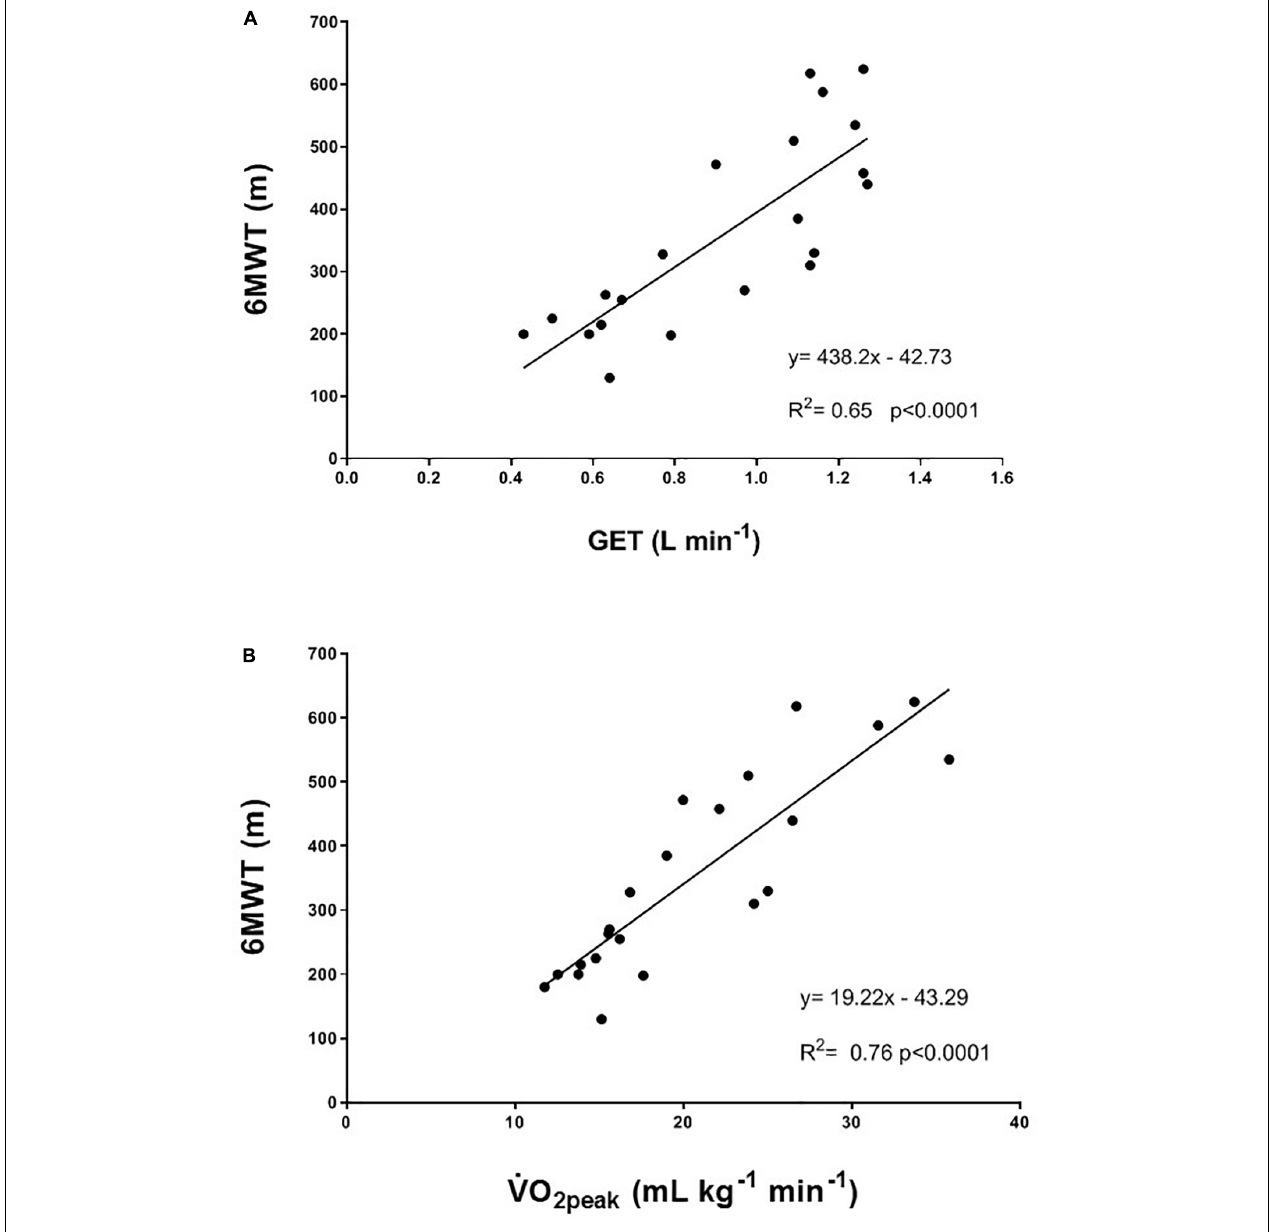
FIGURE 4 | Correlation between (A) gas exchange threshold (GET) and the 6-min walking test (6MWT); and (B) peak oxygen uptake (˙VO 2peak ) and the 6-min walking test (6MWT). Participants from both the TRAIN and UC groups are considered in the